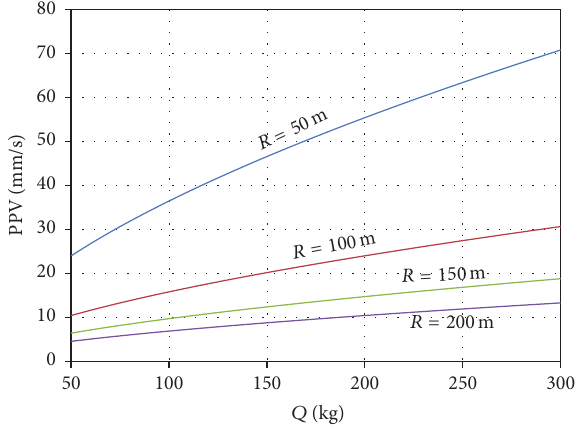
Figure 9: Surface PPV dependent on 𝑄 and 𝐷 .